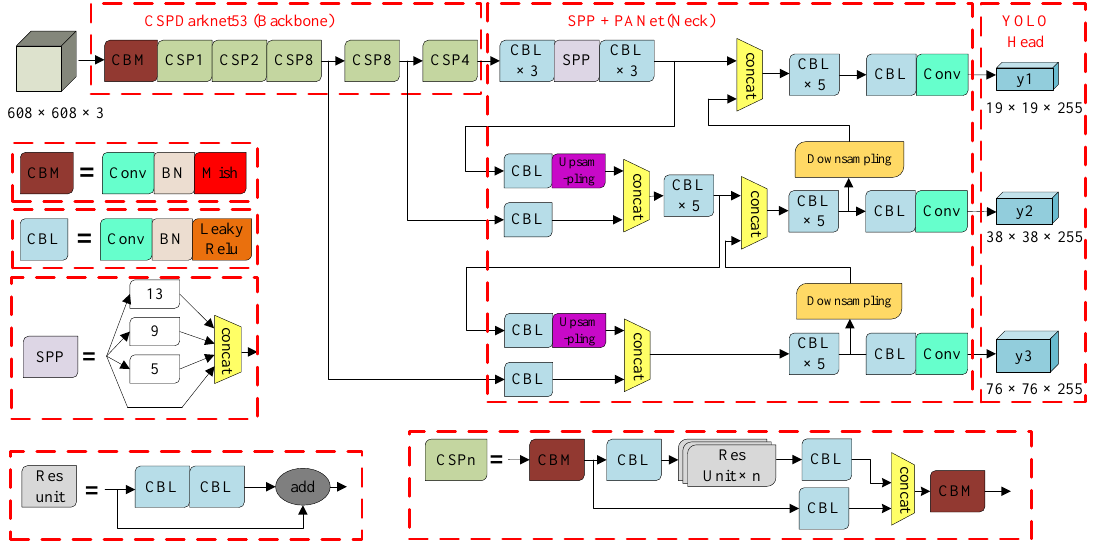
Figure 1. The structure of the original YOLOv4.